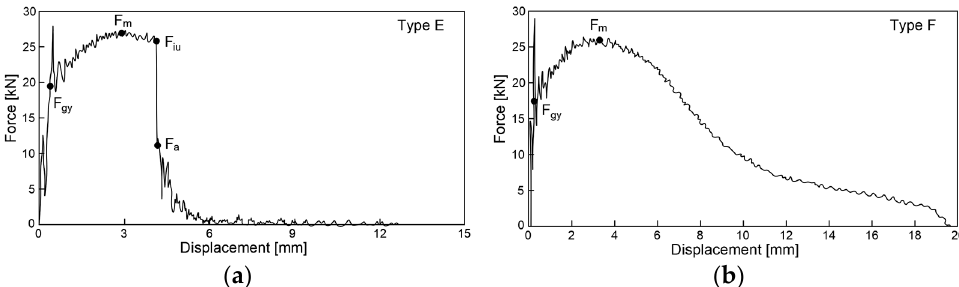
Figure 5. The force–displacement of force application point graphs as characteristics of typical impact strength fractures including: ( a ) category E fracture type, ( b ) category F fracture type. Quali fi - cation following the recommendations of [15].